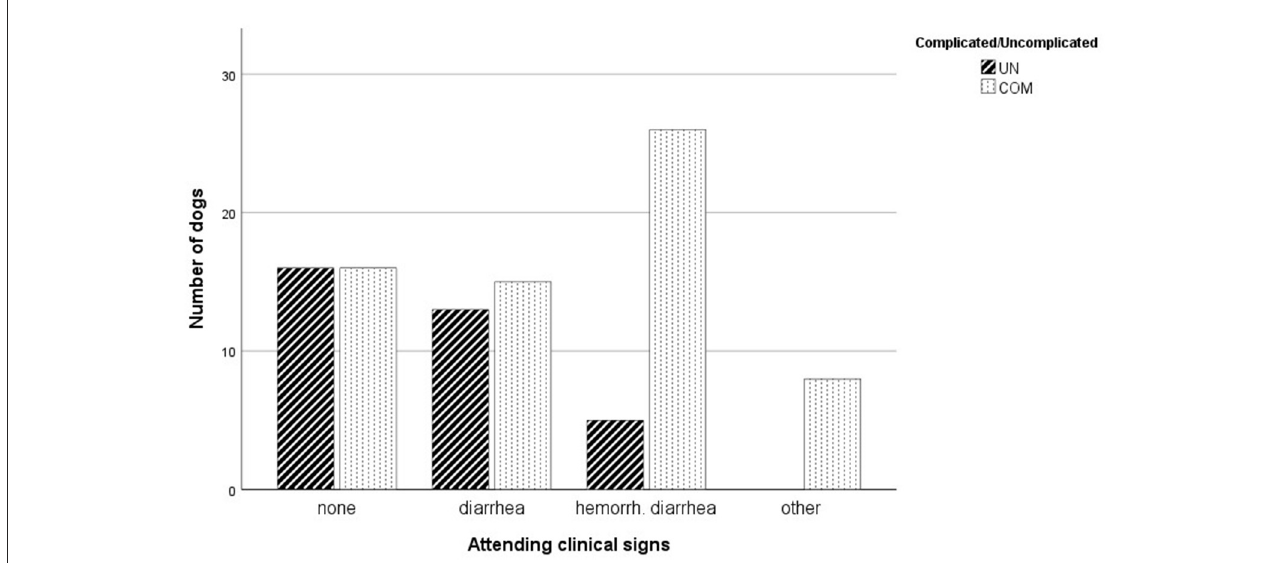
FIGURE1 Attending clinical signs in dogs with uncomplicated (UN) vomiting compared to complicated vomiting (COM). Abbreviation: hemorrh. diarrhea, hemorrhagic diarrhea.